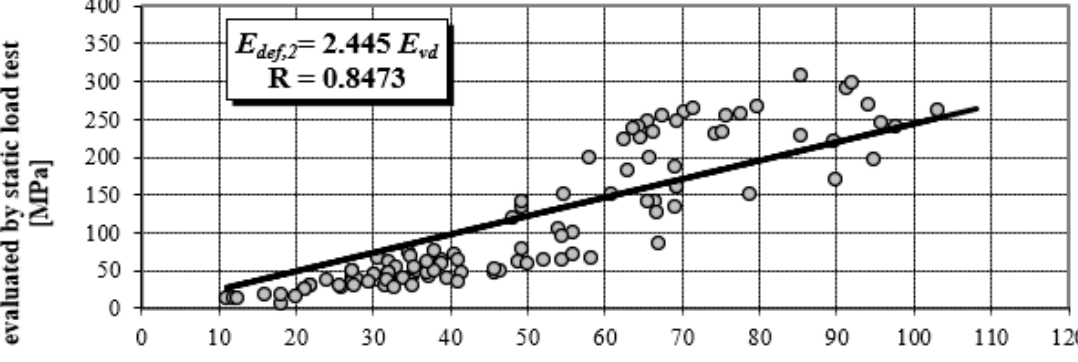
Figure 6. Linear correlation dependency of E def, 2 on E vd.